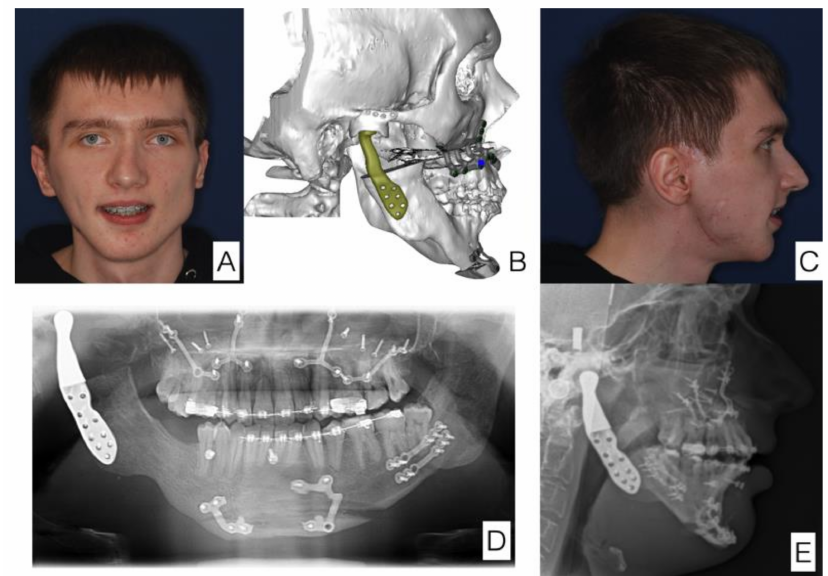
Figure 8. The same patient. The final effect of treatment. Significant improvement in facial symmetry and proportions. ( A ) Anterior view of the face, ( B ) postoperative 3D reconstruction (in line with surgical and 3D planning), ( C ) lateral view of the face, ( D ) orthopantomogram with prosthesis and welding plates visible, ( E ) cephalometry with prosthesis visible.